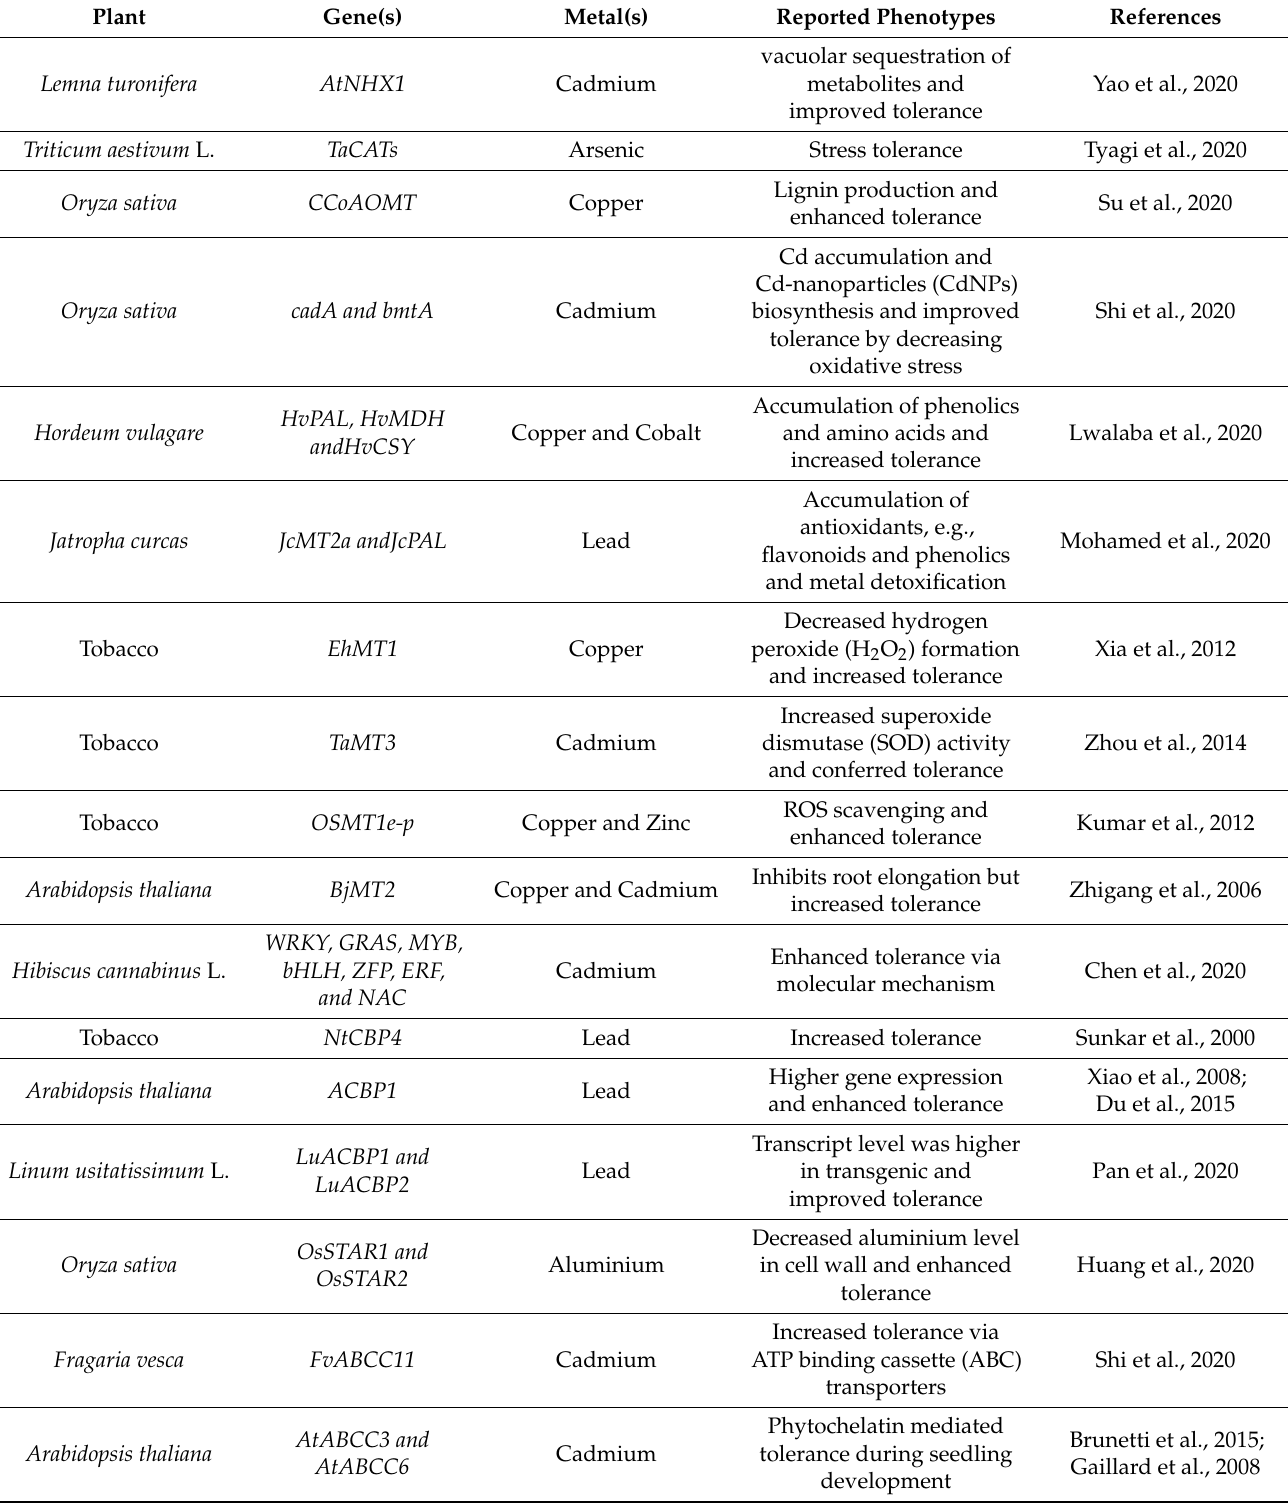
Table 1. List of the genes expressed under toxicities of different